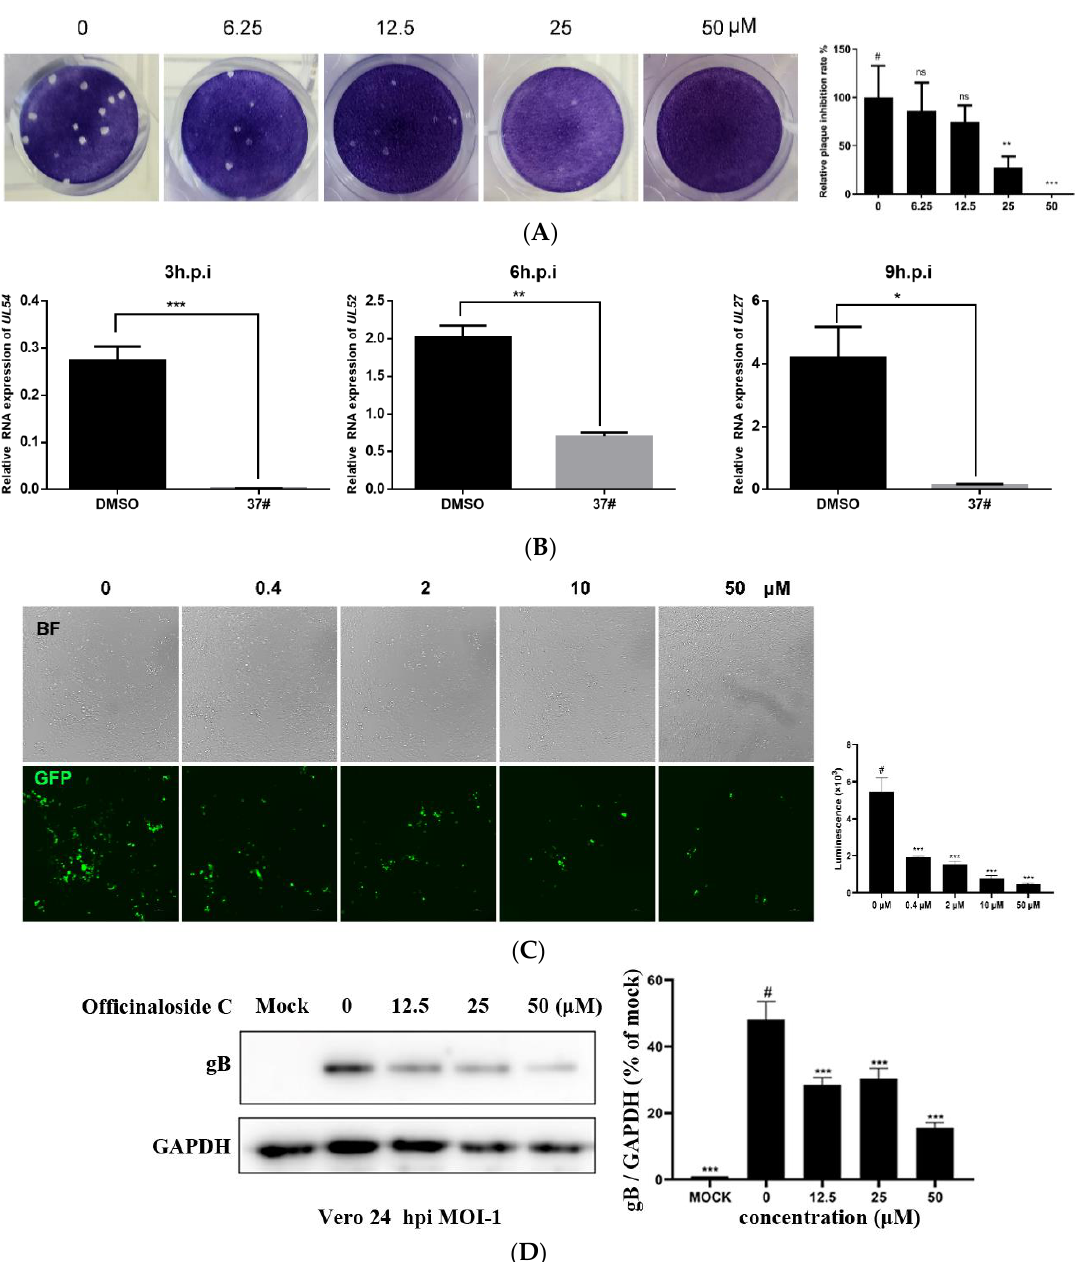
Figure 3. The officinaloside-C-affected virus replication and gene expression in HSV-1-infected Vero cells ( x ± s , n =3). ( A ) Plaque reduction results showed that after adding different concentrations of officinaloside C and HSV-1 virus dilution (30 PFU/well) to Vero cells, officinaloside C can inhibit virus replication. ( B ) RT-qPCR results showed that officinaloside C has inhibitory effects on UL54 at 3 h, UL52 at 6 h, and UL27 at 9 h after HSV-1 infection. ( C ) Fluorescence report test results showed that officinaloside C can inhibit viral replication. ( D ) Vero cells were treated with HSV-1 F in the presence of various concentrations of officinaloside C for 24 h, respectively. Cell lysates were then subjected to a Western blot assay to detect the protein levels of viral protein gB. GAPDH was used as a loading control (*p≤0.05, **p≤0.01, ***p≤0.001 , # control group).